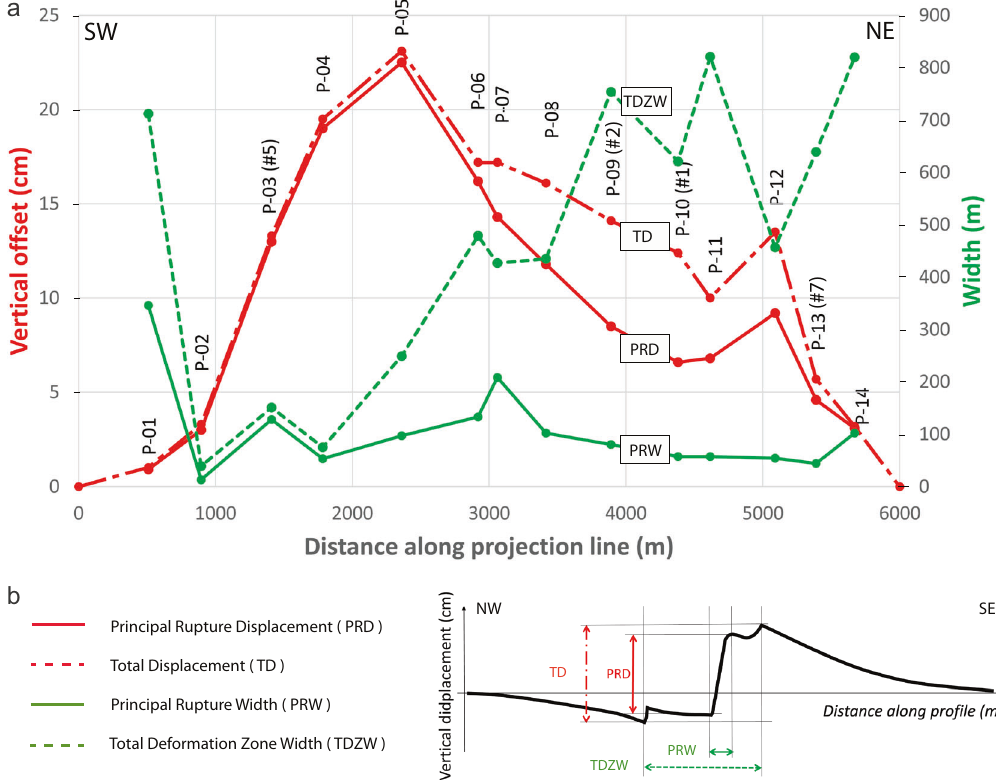
Fig. 5 Distribution of the vertical co-seismic slip and width of the deformation associated with the Le Teil earthquake. a Co-seismic slip distribution and width of the deformation zone inferred from InSAR data, along the projection line indicated in Fig. 4a. This graph is based on 14 across fault pro fi les that were traced at key locations where we observed deformation features in the fi eld. Those pro fi les allow the estimation of vertical displacement across the rupture (vertical offset), together with the width across which this displacement is accommodated. As shown in b , we distinguish two levels of observation aperture along each pro fi le: the total deformation zone (TD and TDZW) that describes the whole deformation band, and the principal rupture (PRD and PRW) where most of the vertical offset is concentrated with the highest gradient. See Supplementary Notes for more